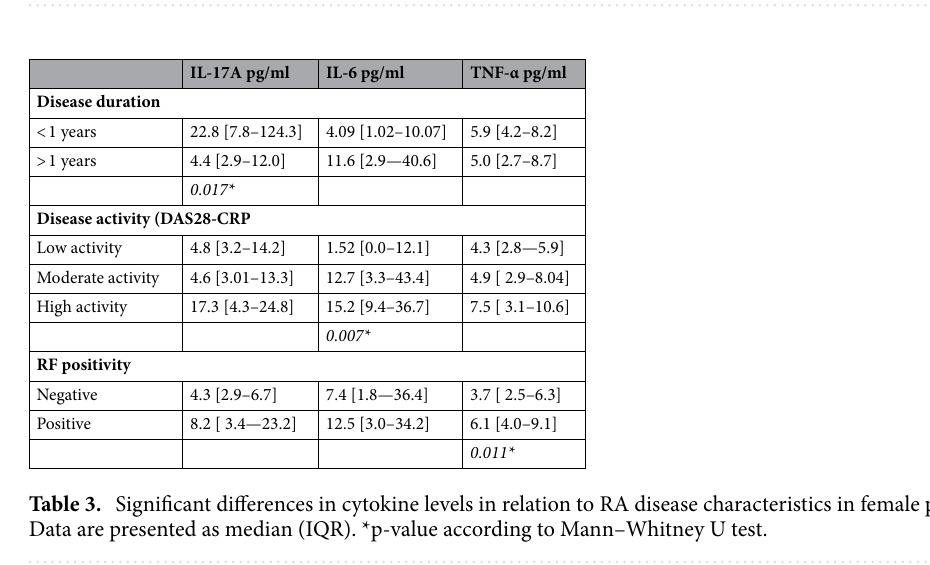
Figure 4. Radial chart visualizing mean cytokine levels in controls ( A ) and patients on low dose corticosteroid treatment ( B ), csDMARDs ( C ), and TCZ ( D ). Cytokine variables were normalized, mean-centered, and unit variance scaled.